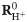
H+ + (H2O)1-6 initial conditions.A given water cluster (not depicted for clarity’s sake) is placed at rest with its center of mass at the origin of the coordinate axes and with its major (pseudo-)plane of symmetry with maximum coincidence with the x-y plane. The H+ projectile is initially prepared with position and momentum RH+0 and PH+0 and with impact parameter b (Panel I). Different projectile-target relative orientations Ω = (α, β, γ) are generated by rotating RH+0 and PH+0 through the extrinsic Euler angles γ (Panel I), β (Panel II), and α (Panel III) around the space-fixed z, y, and z axes, respectively. The definite initial conditions of the H+ projectile to start the simulations, RH+i and PH+i, are shown in Panel IV (cf. text for more details).